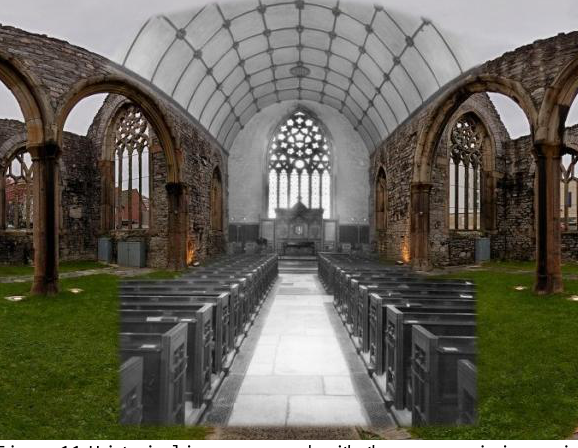
Figure 11 Historical image merged with the panoramic image is the beginning of 3D reconstruction.